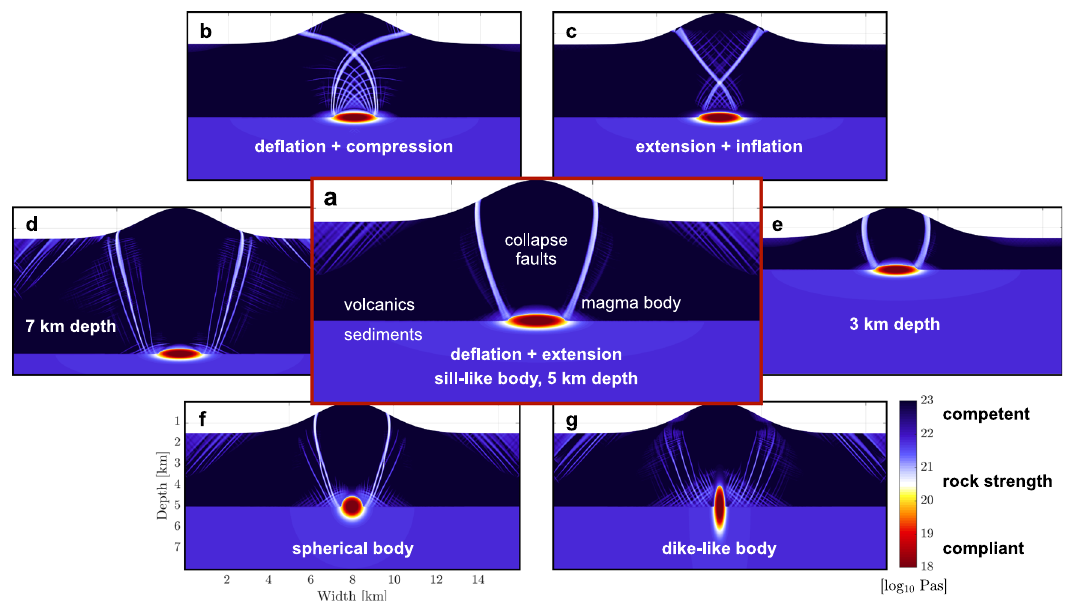
Fig. 5 | Results of volcano deformation models show emerging collapse frac- turegeometries.a Best- fi tcaseofde fl atingmagmabodyundertectonicextension, steepfailurezonesextendlaterallyfrombaseofmagmabodytoedi fi ce fl anks; b for de fl ationcombinedwithcompression,and c forextensioncombinedwithin fl ation, steep cross-cutting fracture zones emerge from roof of magma body.